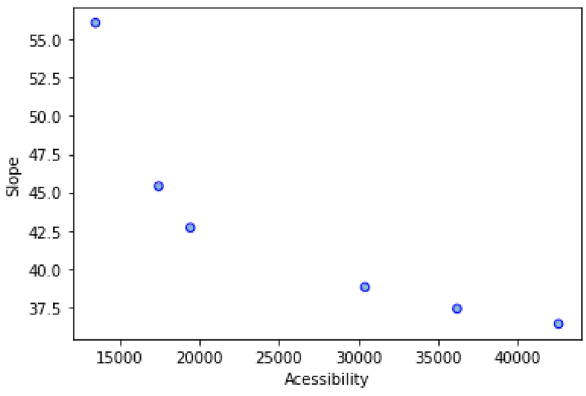
Fig. 5 Pareto front for Path L 2 considering the objective measures, Accessibility and